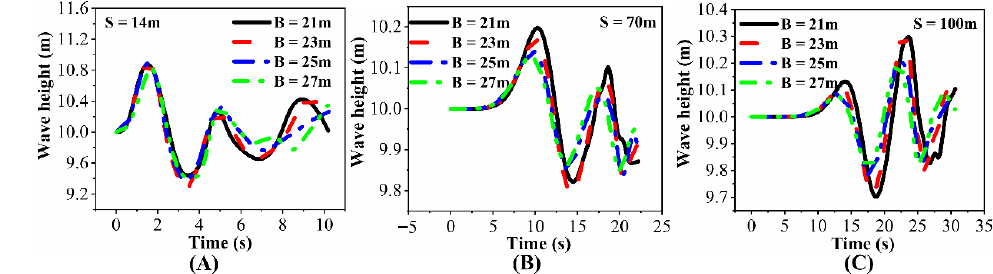
Figure 6. Wave surface variation of different observation places in different widths of water level: ( A ) S = 14 m; ( B ) S = 70 m; ( C ) S = 100 m.